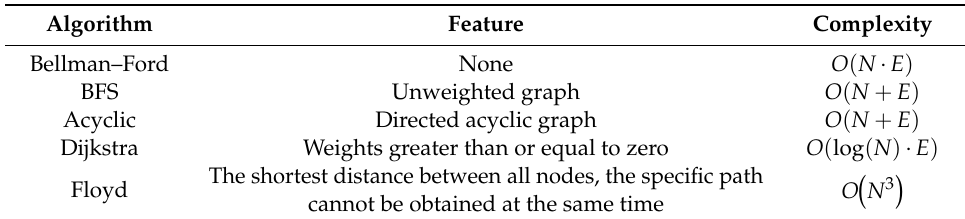
Table 1. Shortest path